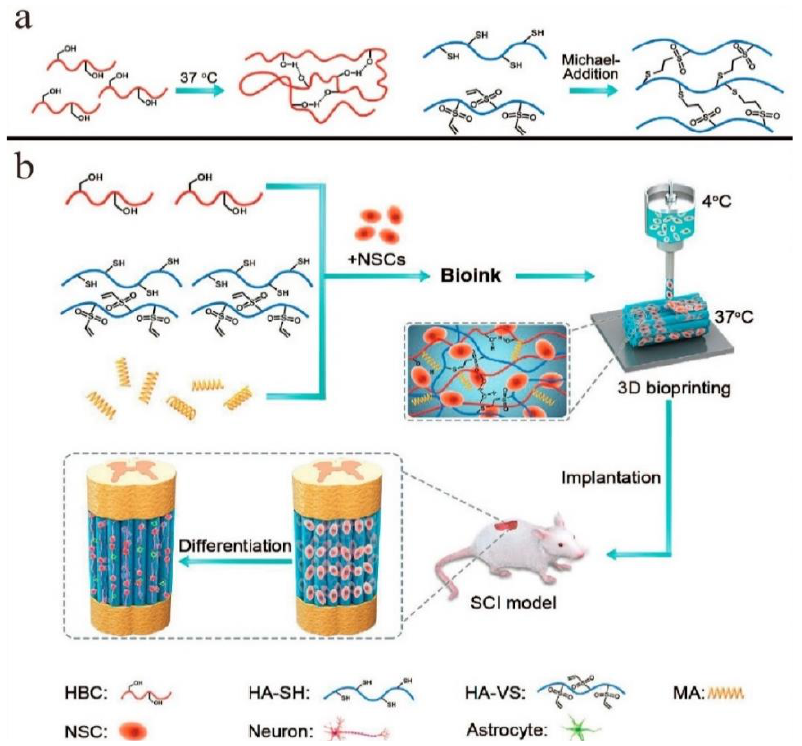
Figure 12. Schematic representation of the NSC-laden bioprinted neural tissue constructs for in vivo SCI repair. ( a ) The crosslinking reactions during and after the 3D printing of the HBC/HA/MA bioink and ( b ) 3D bioprinting of the NSC-laden white matter of spinal cord-like scaffold and its application for in vivo SCI repair. Reprinted from [36], Copyright 2021, Elsevier.